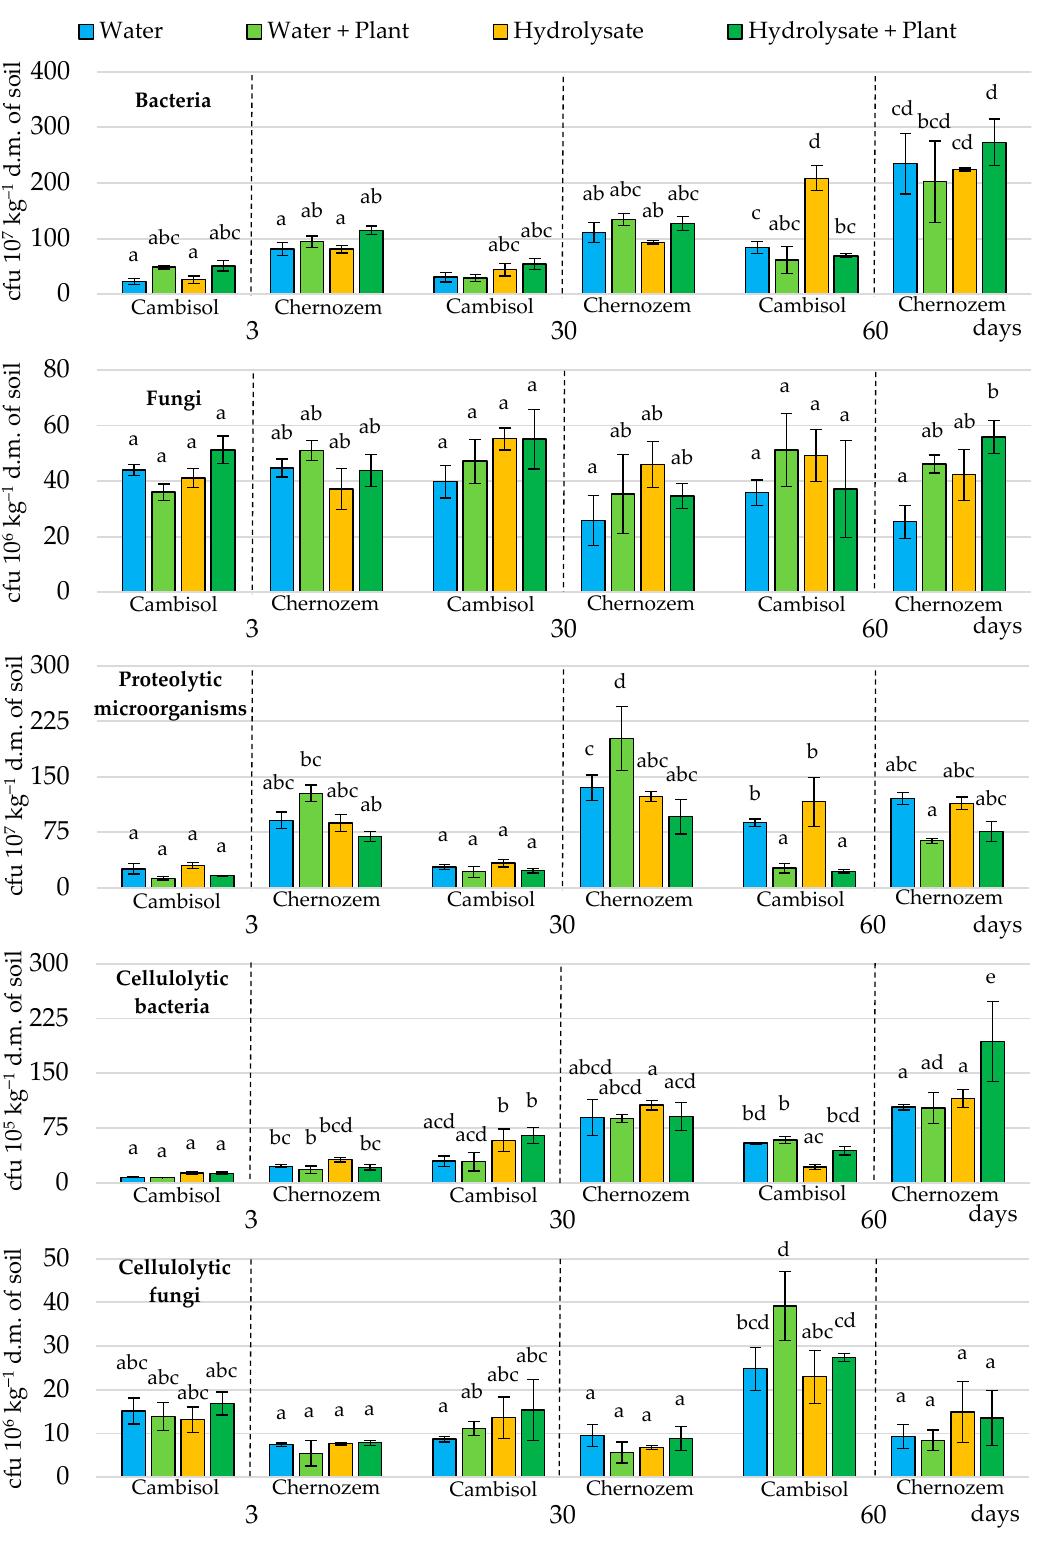
Figure 1. Dynamics of changes in the numbers of selected groups of microorganisms in different experimental variants; letters, i.e., a, b, c, d denote the means that form homogenous groups (HSD— Tukey post hoc test for multivariate ANOVA). When two compared means were assigned the same letter (e.g., a, a or ab, ab) that means did not differ significantly (at α = 0.05); if means are marked with different letters (e.g., a and b, etc.) they differ significantly from each other (at α = 0.05). Due to the high content of organic nitrogen compounds in keratin hydrolysates, it was justified to study the dynamics of changes in the abundance of proteolytic microor- ganisms. The data in Figure 1 show that the number of proteolytic microorganisms in